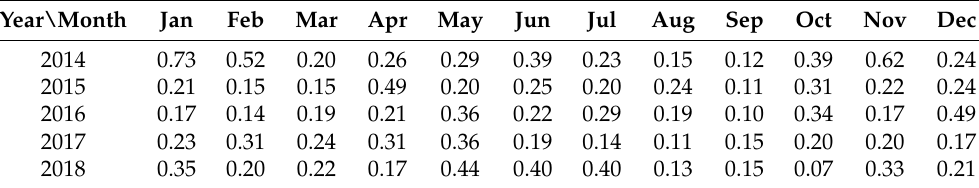
Table A12. Monthly standard deviations for sea surface height for the years 2014–2018.